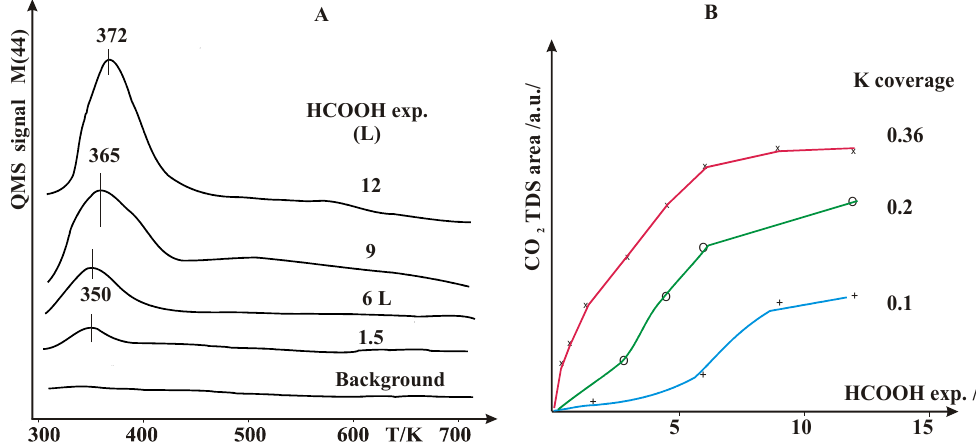
Figure 3. ( A ) Thermal desorption spectra of CO 2 from low potassium coverage, ( Θ K = 0.1). ( B ) The amount of desorbed CO 2 as a function of potassium coverage after different HCOOH exposures at 300 K.